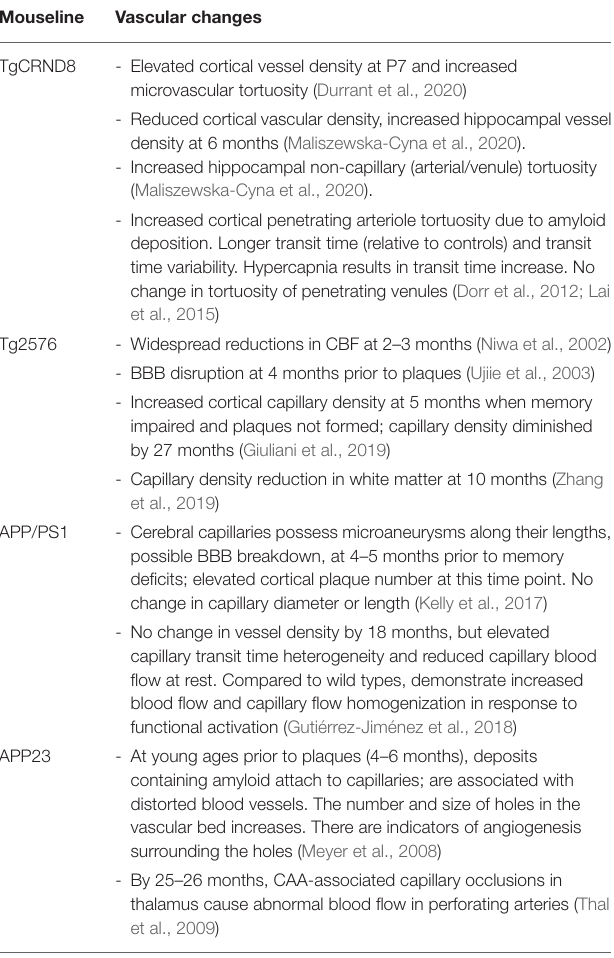
TABLE 1 | Summary of cerebral vascular changes in the main mouse models